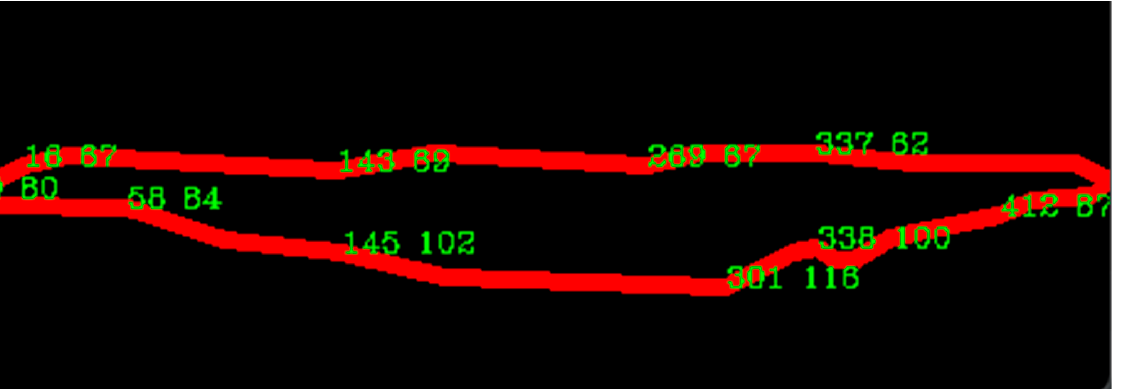
Figure 4. Contouring and Writing Coordinates (Displayed in green numbers, number of coordinates reduced for display clarity) for Female Side View Model.